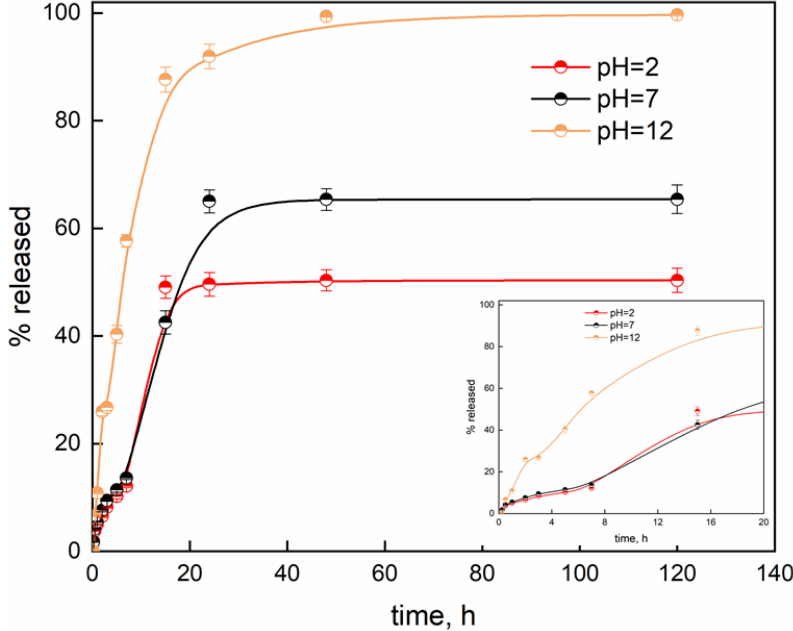
Figure 5. Release kinetics of Lambrusco polyphenol-loaded soybean-based beads.